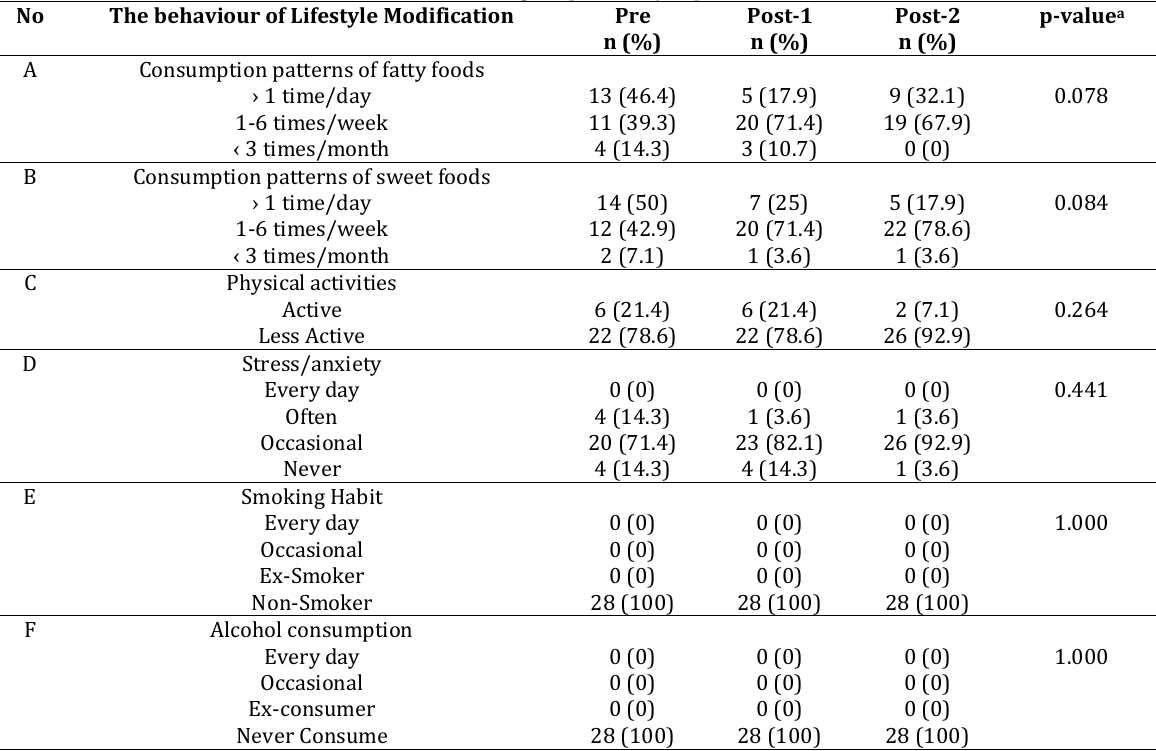
Table 4. Behaviour of modification of the control group’s lifestyle patterns